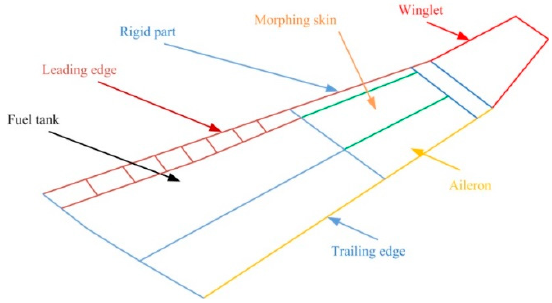
Figure 4. The demonstrator for the morphing wing of the regional aircraft.